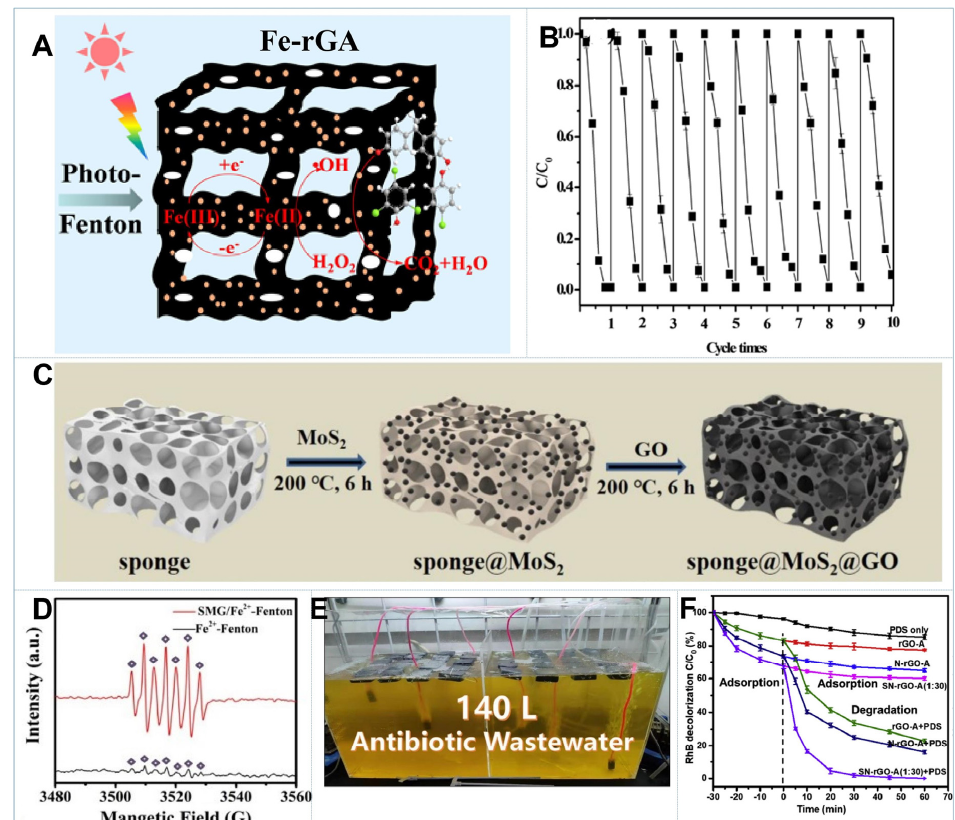
Figure 6. ( A ) Schematic diagram of photo-Fenton reaction over FeO(OH)-rGA [152]. ( B ) The reusabil- ity of the FeO(OH)-rGA aerogel after 10 cycles under visible light irradiation [152]. ( C ) Illustration of the fabrication processes of spong@MoS 2 @GO [158]. ( D ) EPR spectra for the detection of HO • using DMPO as the spinning trapping agent [158]. ( E ) Photograph of the 140 L degradation device [158]. ( F ) RhB degradation by PDS activation over different catalysts